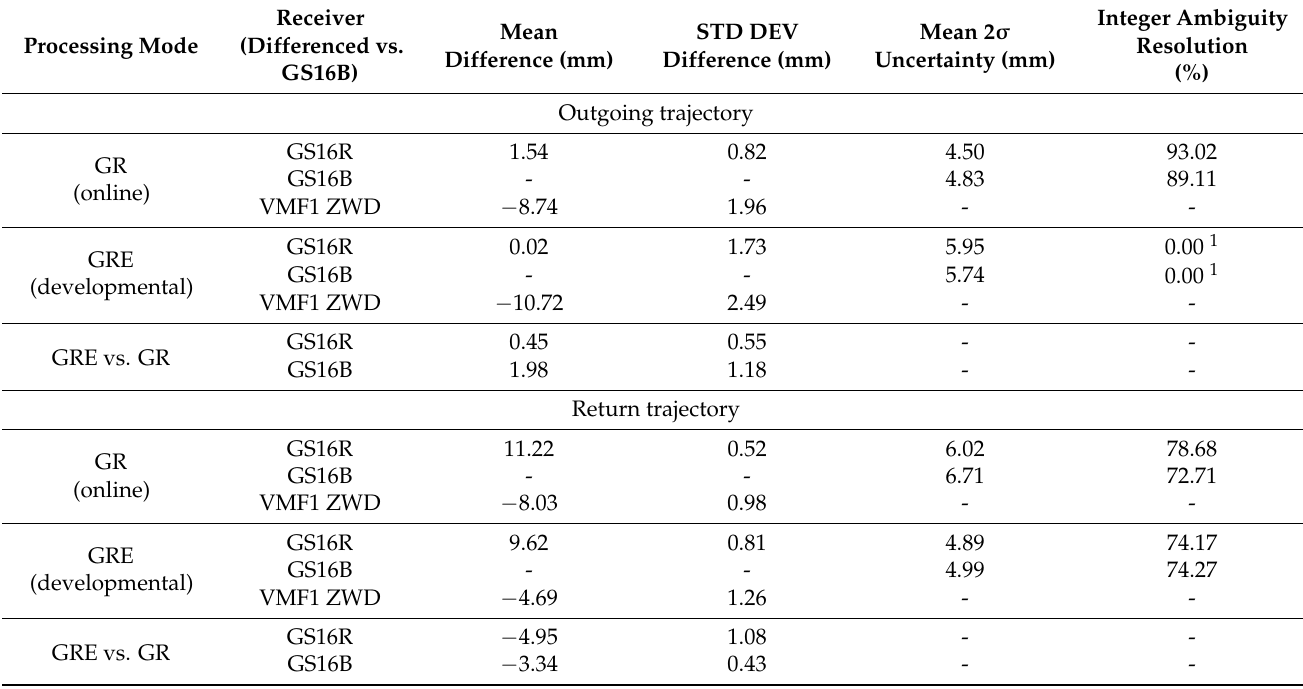
Table 3. Kinematic dataset B ZWD profile mean differences, standard deviations, and average 2 σ uncertainties for GR, GRE, and VMF1, and integer ambiguity resolution success rates.